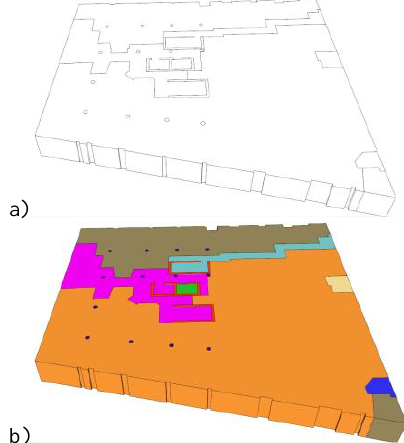
Figure 2. 3D Visual solutions, a- B&W (boundaries in black and volumes in white) and b- monitoring the colour (boundaries in black and volumes with distinct